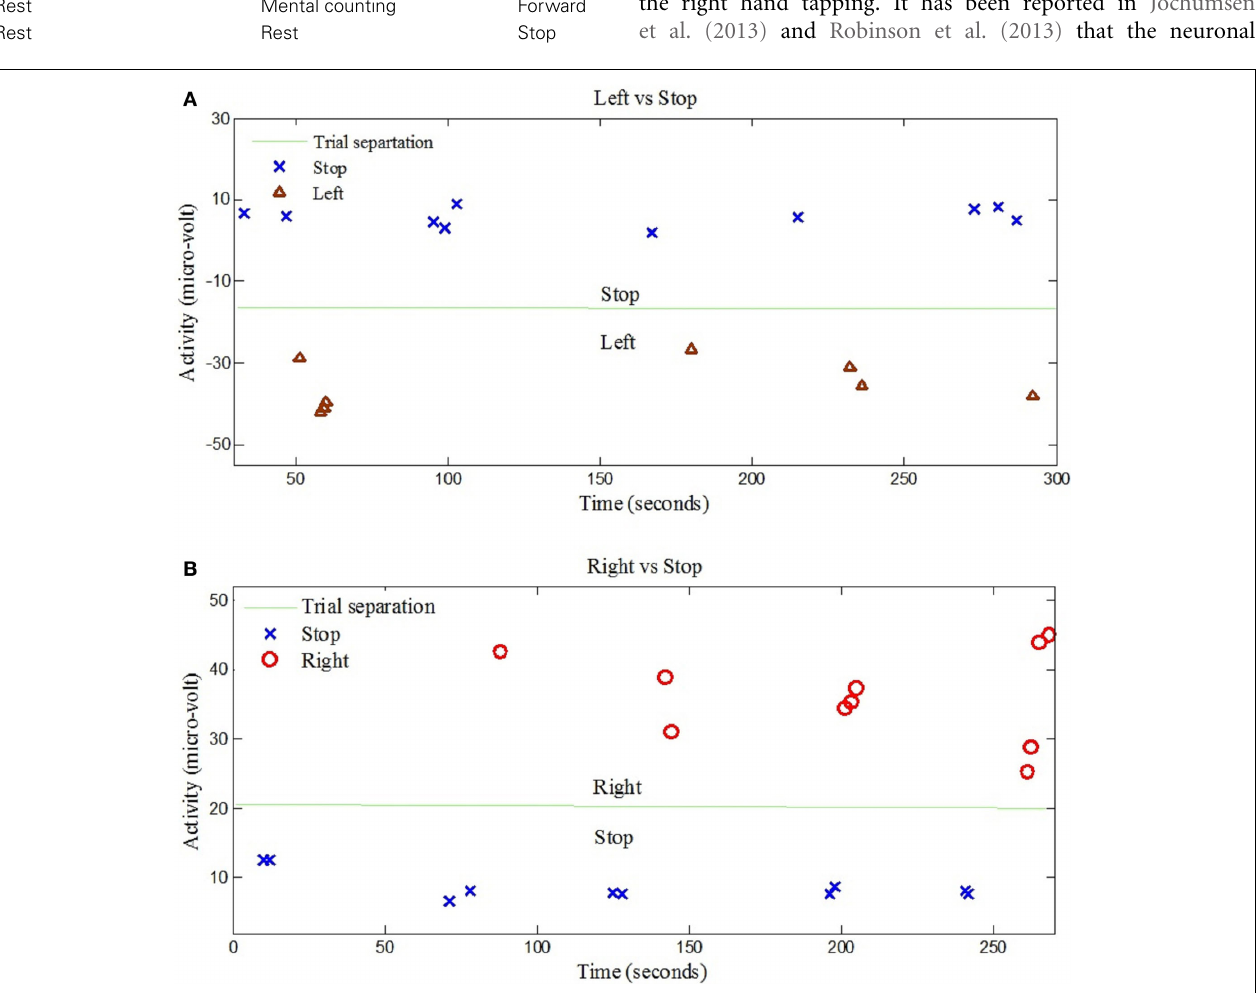
FIGURE 6 | EEG data classification for left and right control commands. (A) Shows the classification of trials for “Left” and “Stop” command signals for Subject 7, (B) Shows the classification of trials for “Right” and “Stop” command signals for Subject 6.